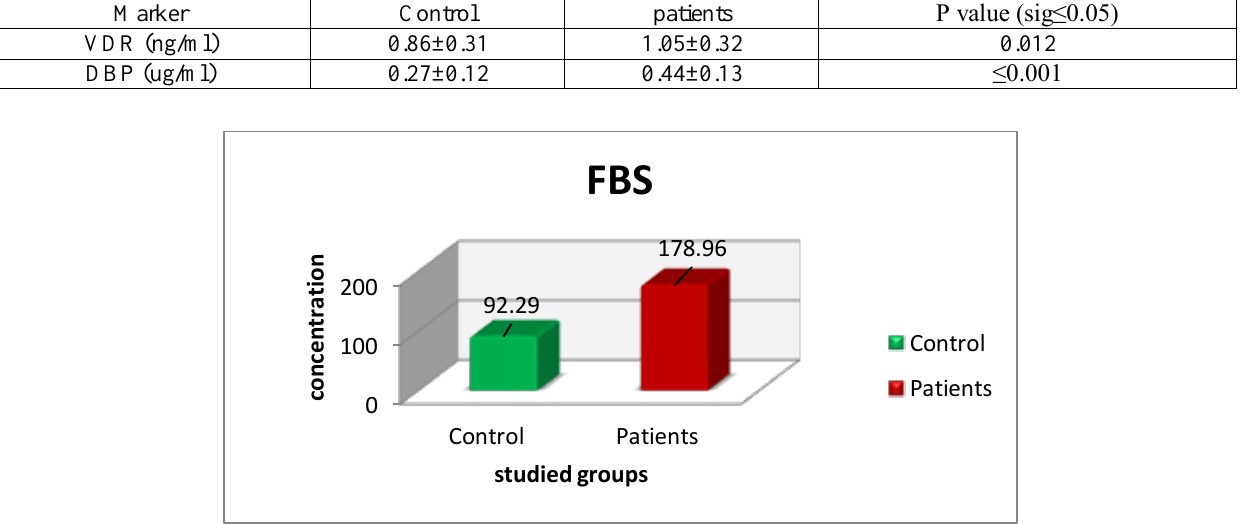
Table 3: Levels of vitamin D receptor and vitamin D binding protein.